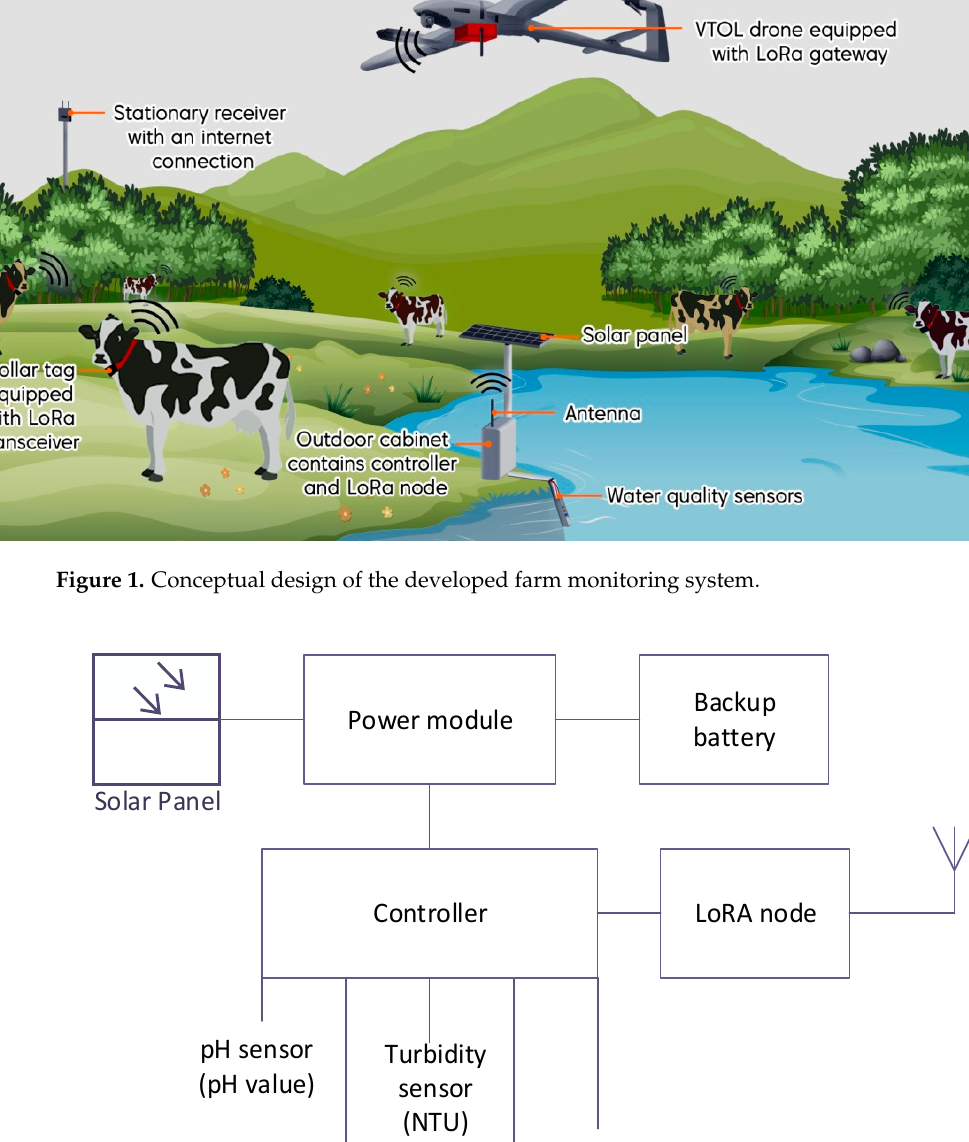
Figure 1. Conceptual design of the developed farm monitoring system.